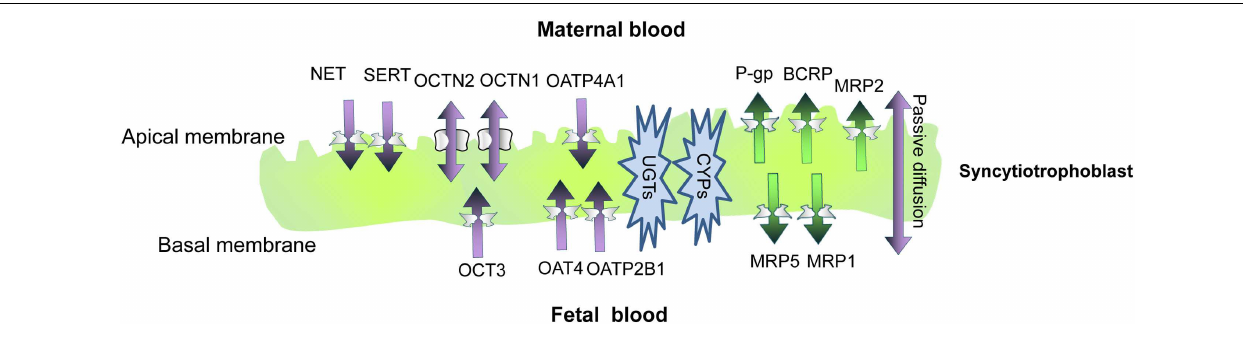
OATP, organic anion-associated polypeptide; OAT, organic anion transporter; OCT, organic cation transporter; OCTN, organic cation/carnitine transporters; SERT, serotonin transporter; NET, norepinephrine transporter; ENT, equilibrative nucleoside transporter; CYP, cytochrome P450; UGT, uridine diphosphate